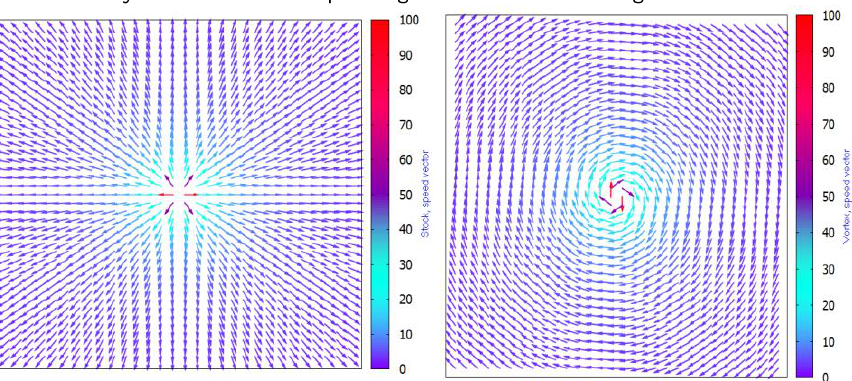
Fig. 1. The potential velocity of a plane flow of an ideal fluid, which describes the motion of the source (left) and vortex flow (right).